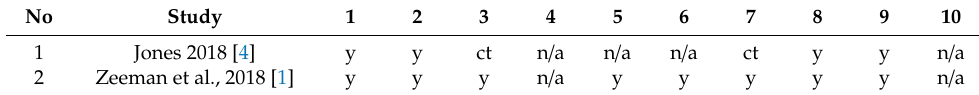
Table 4. Critical Appraisal Skills Programme (CASP) quality assessment of